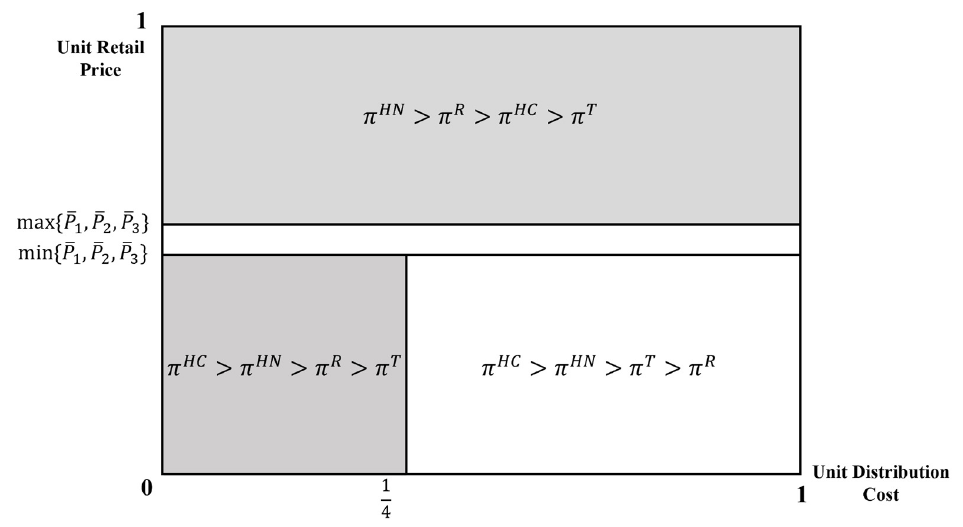
Figure 11. Overall business model selection in the complementary and competition case.